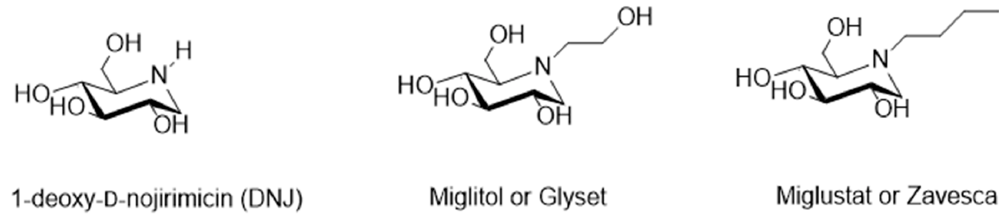
Figure 10. Chemical structure of DNJ, Miglitol and